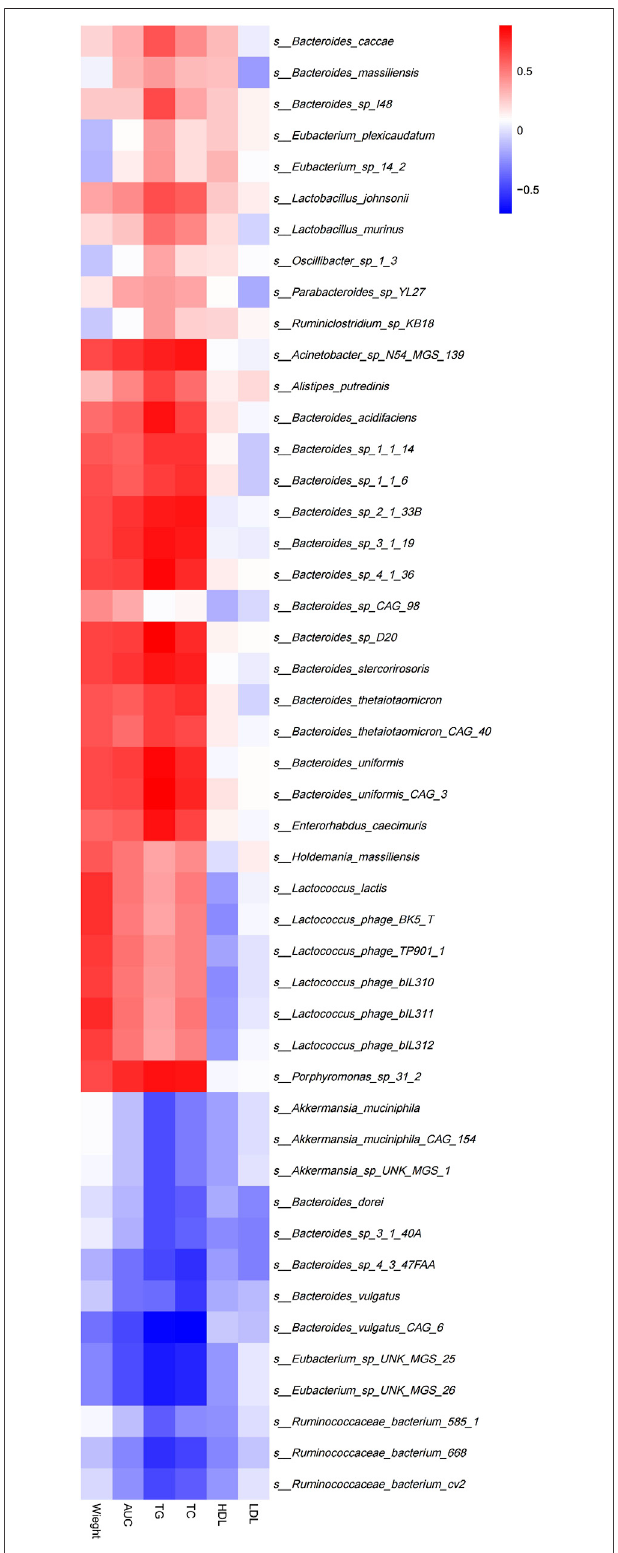
FIGURE 7 | microbiota and clinical characteristics in each group. AUC, area under the curve (AUC) during OGTT; TG, triglycerides; TC, total cholesterol; LDL, low-density lipoprotein; HDL, high-density